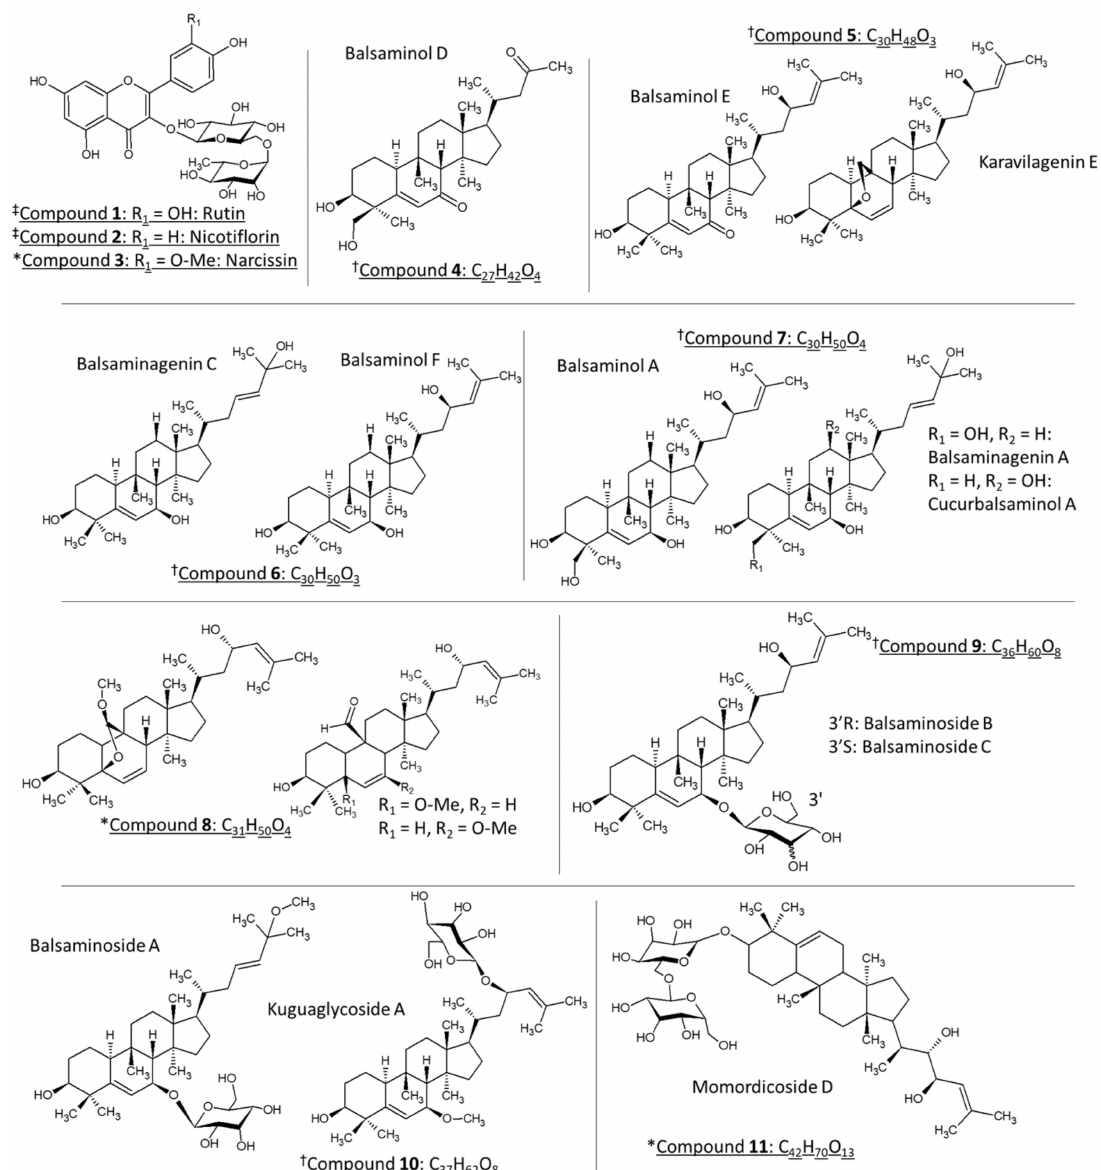
Figure 1. The chemical structures of the compounds identified in M. balsamina in the present work. Compounds marked with ‡ ( 1 and 2 ) have been tentatively identified in M. balsamina using LC-MS, whereas compounds marked with † have been previously isolated and characterized in M. balsamina . Lastly, compounds symbolized with * have been tentatively identified in the present work based on high and low collisional energy mass spectrometry and ultraviolet spectroscopy. Compounds 5 – 8 and 10 with similar molecular formulas are grouped